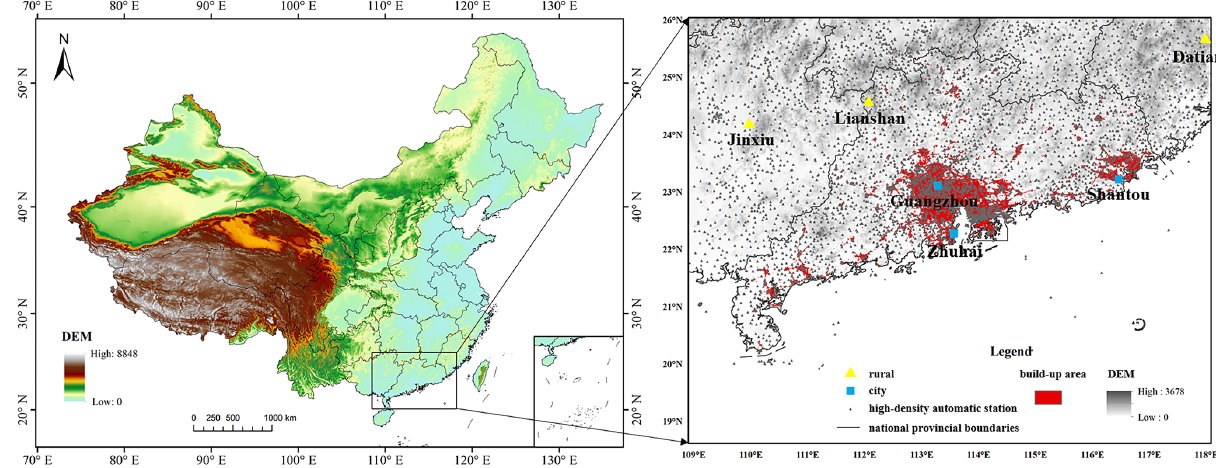
Figure 1. Distribution of automatically operated meteorological stations over the study area.